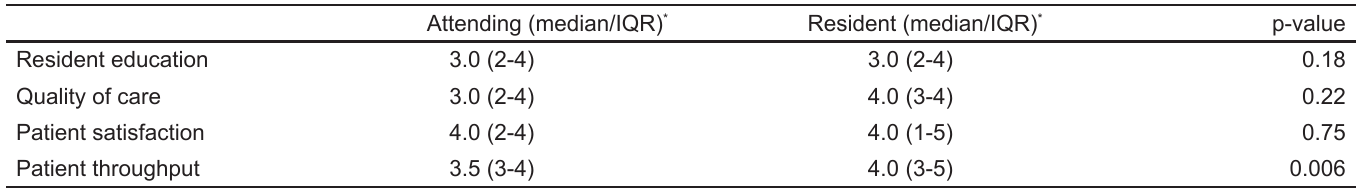
Table 2 . Attending and resident perceived impact of physician in triage on resident education, quality of care, patient satisfaction and